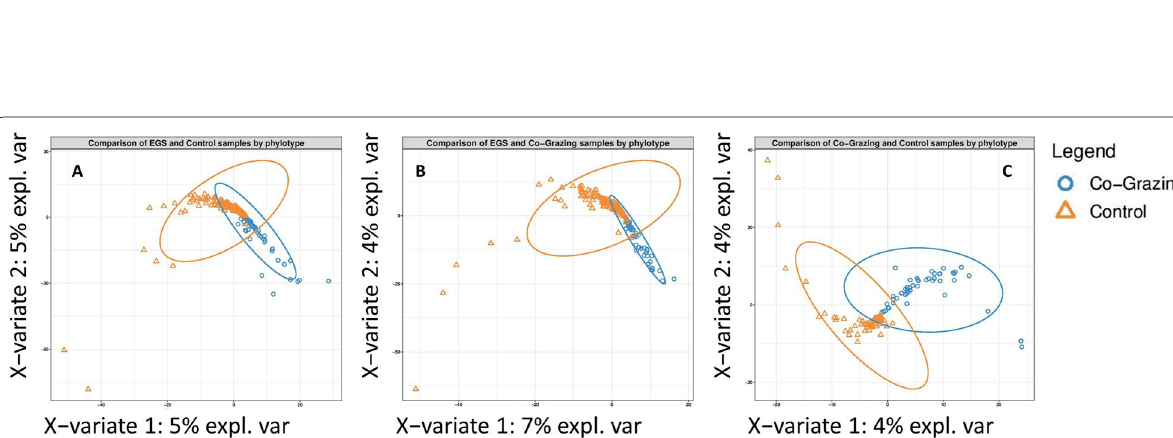
Fig. 4 Partial Least Squares Discriminant Analysis (PLS-DA) plots showing separate clustering of all samples from A EGS vs CTRL, B EGS vs CoG and C CoG vs CTRL, at phylotype level. Weighted UniFrac distance analysis identified significant inter-group dissimilarities (Additional file 1; Table S7). Confidence ellipses show 95% confidence level